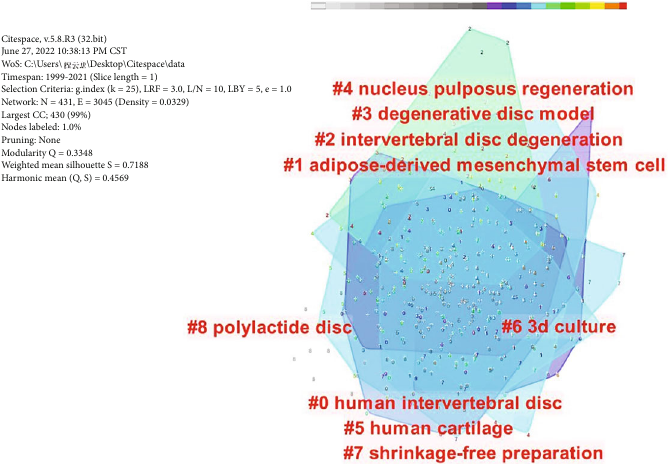
Figure 7: Keywords clusters on stem and progenitor cells in intervertebral discs. (A point in the fi gure represents a keyword. The color of the point represents di ff erent clusters, and the size of the point represents the co-occurrence for each keyword. The more the co-occurrence, the larger the point; # represents di ff erent cluster labels, #0 human intervertebral disc, #1 adipose-derived mesenchymal stem cell, #2 intervertebral disc degeneration, #3 degenerative disc model, #4 nucleus pulposus regeneration, #5 human cartilage, #6 3d culture, #7 shrinkage-free preparation, and #8 polylactide